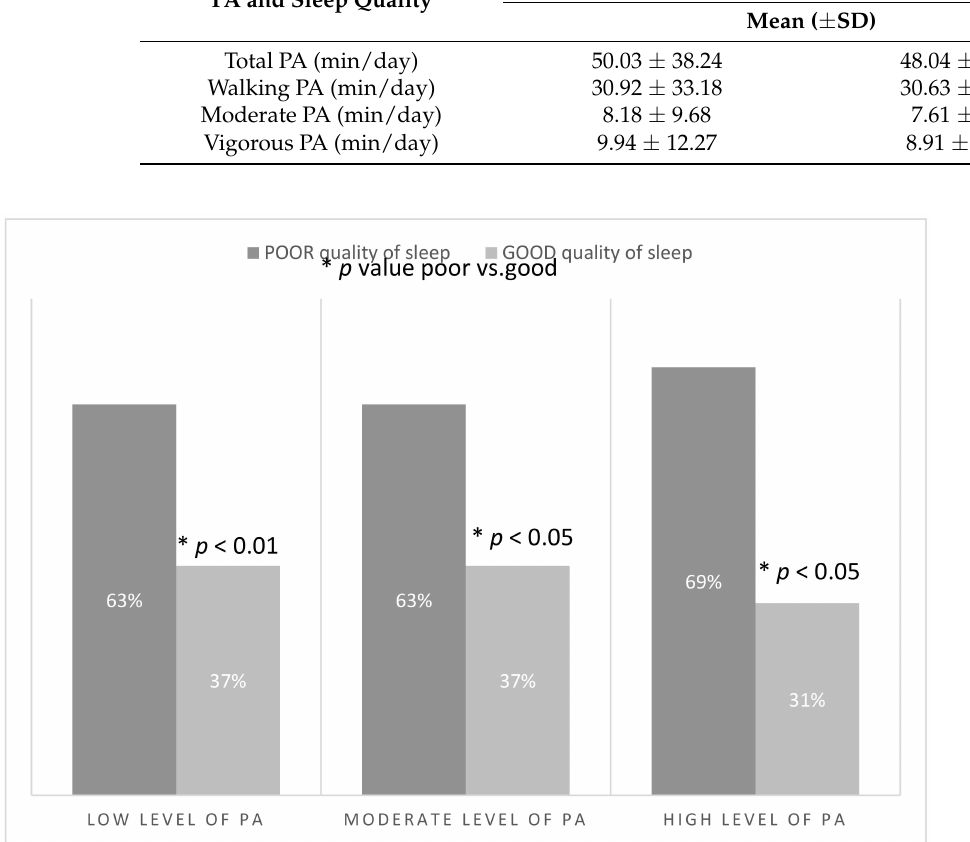
Figure 4. Number and the percentage of participants ( n = 1956) with a specific quality of sleep depending on the level of